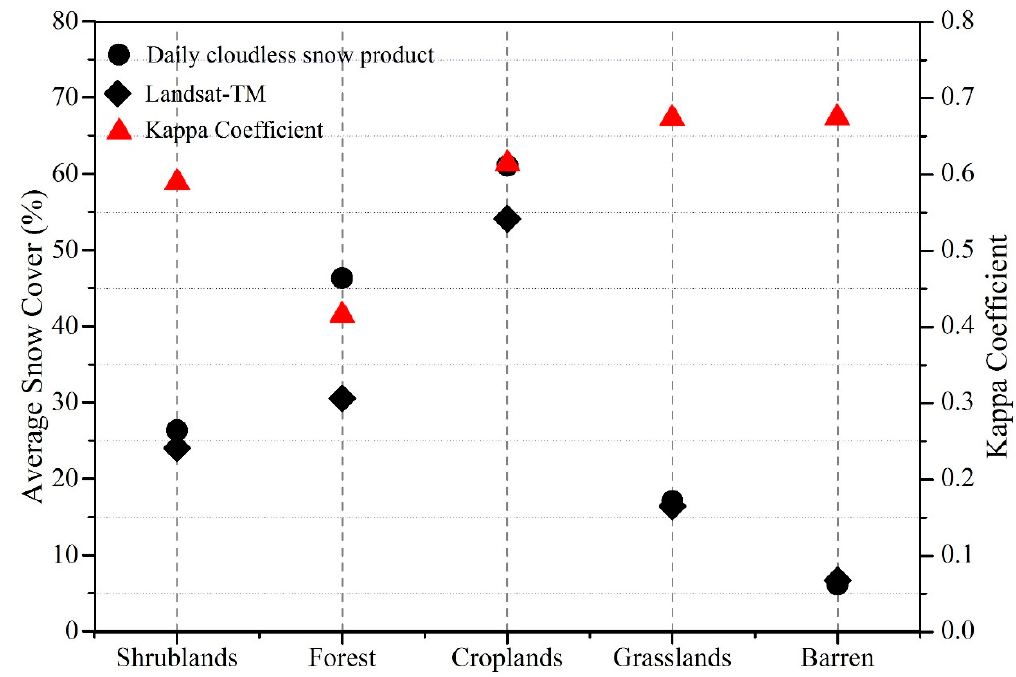
Figure 2. Comparison of the cloud-free daily snow product and Landsat Thematic Mapper (TM) for different land cover types.